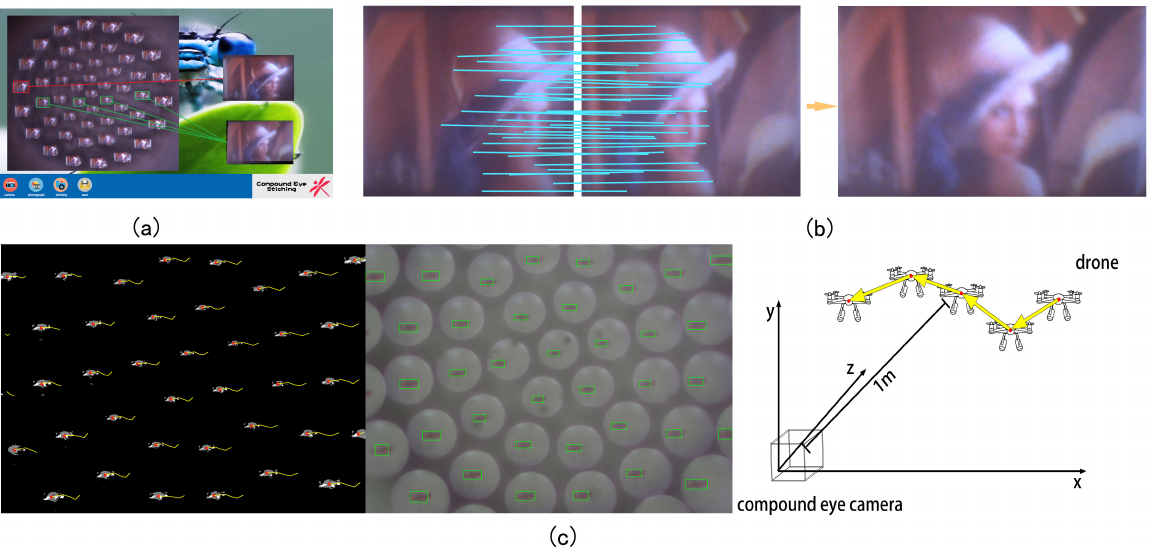
Figure 8. ( a ) Stitching software. ( b ) Schematic diagram of splicing. ( c ) Moving-drone